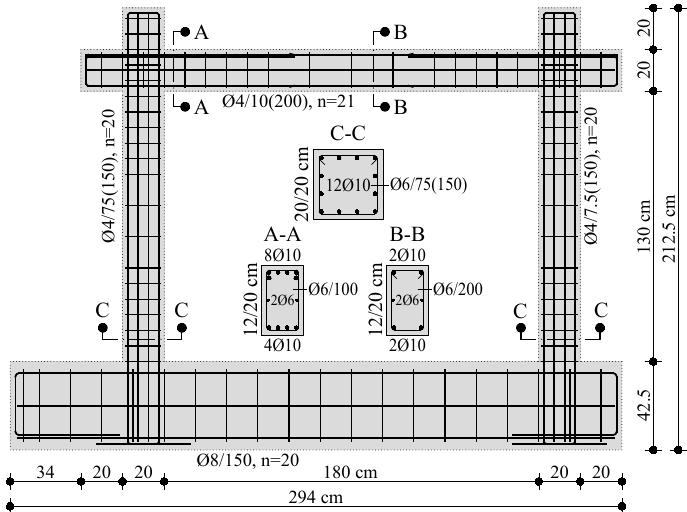
Figure 1. RC frame specimens, reinforcement details, and element cross-sections (A-A, B-B and C-C). The observed damage on the specimens ranged from Moderate to Heavy , with Cracks